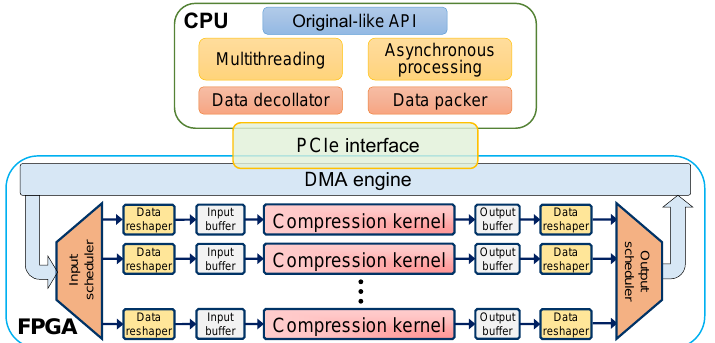
Figure 2. The architecture of the HybriDC system based on the CPU-FPGA heterogeneous